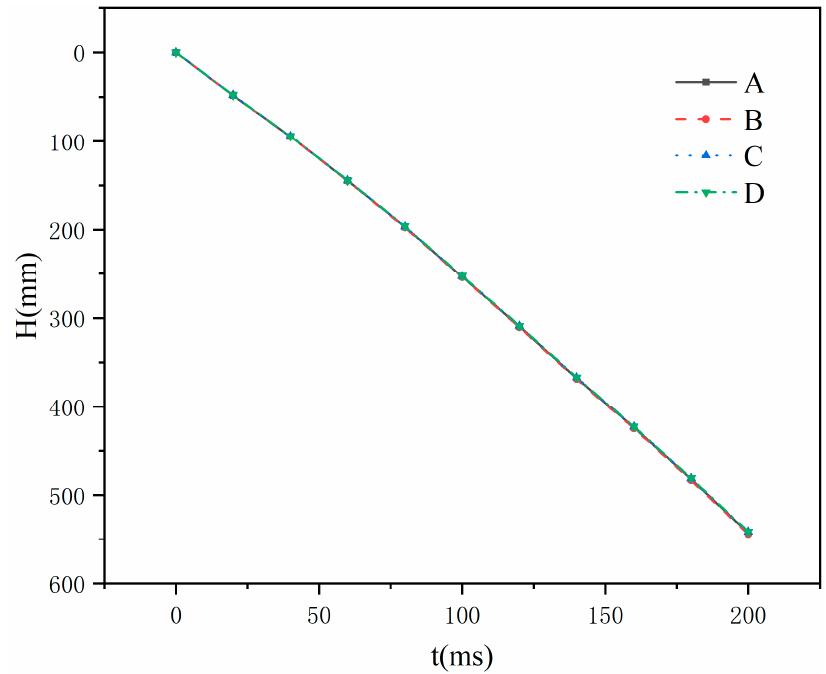
Figure 9. The 90-degree hydrophobic model’s ballistic curve at an initial speed of 2.2 m/s.